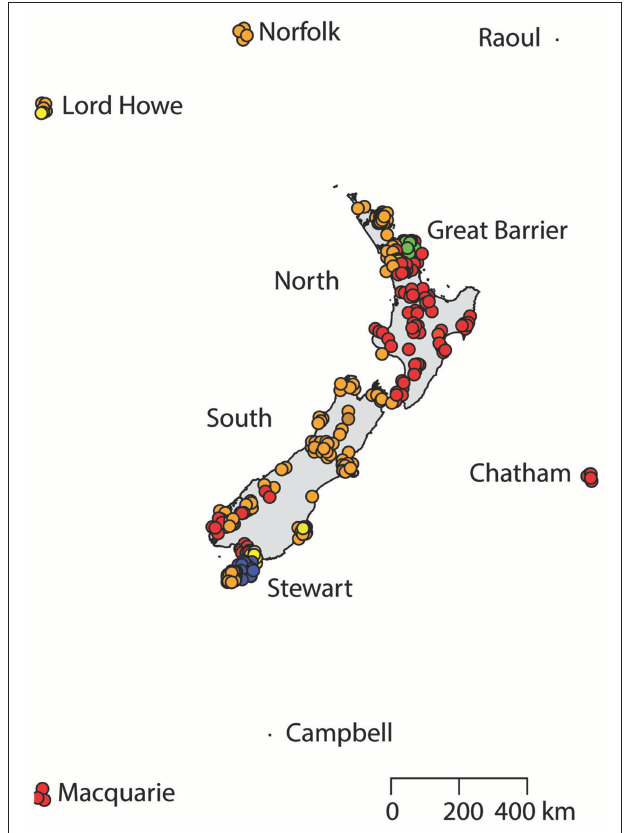
FIGURE 4 | The distribution of R. rattus haplotypes across New Zealand and surrounding islands.